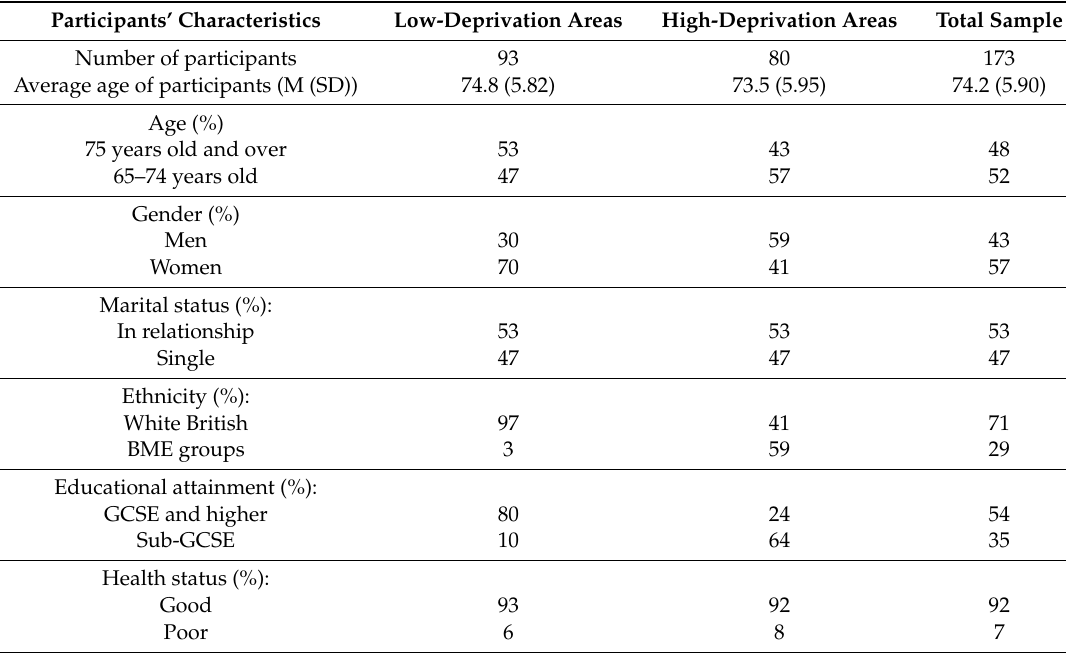
Table 3. Sample characteristics in low- and high-deprivation areas and in total.